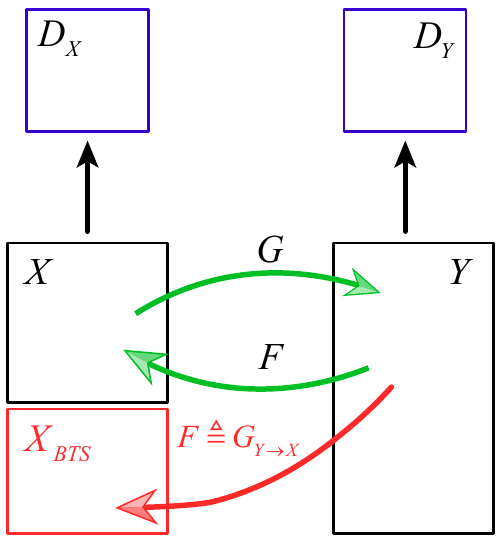
Figure 3. Bootstrapping of the statistics of the discriminator D X in the scarce domain X , by adding a set of novel examples X BTS to the original pool of unlabeled training data X . Bootstrapped samples are randomly generated by G Y → X